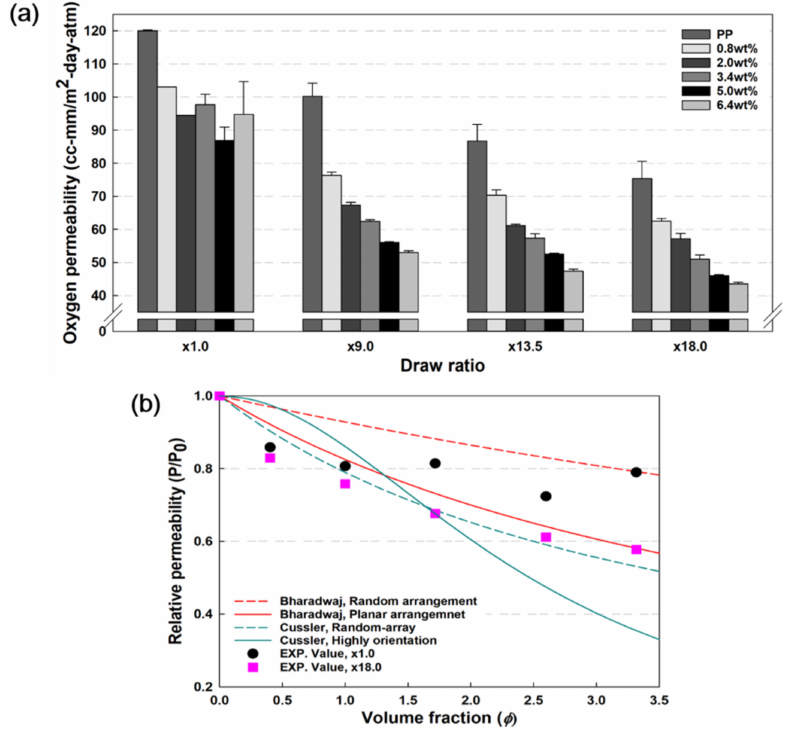
Figure 8. ( a ) Oxygen permeability results of PP and PP/nanoclay nanocomposites according to the increase in draw ration at RH 0% and ( b ) Relative permeability of PP/nanoclay nanocomposites with different content of nanoclay and draw ratio with different model predicted gas